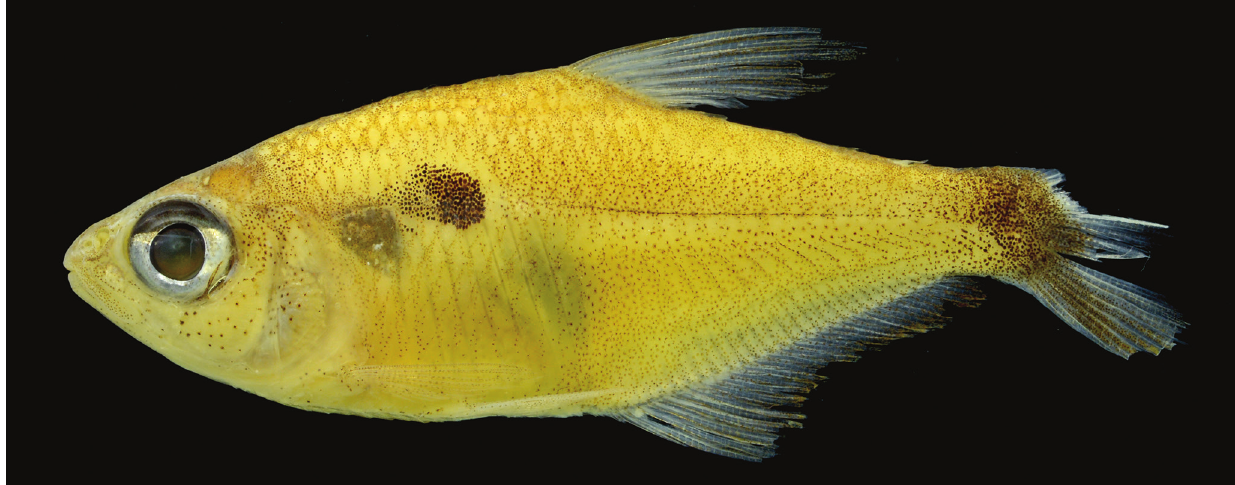
Fig. 1. Phenacogaster julliae , MZUSP 123642, holotype, unsexed, 27.4 mm SL, rio Salitre, Bahia state, Brazil.